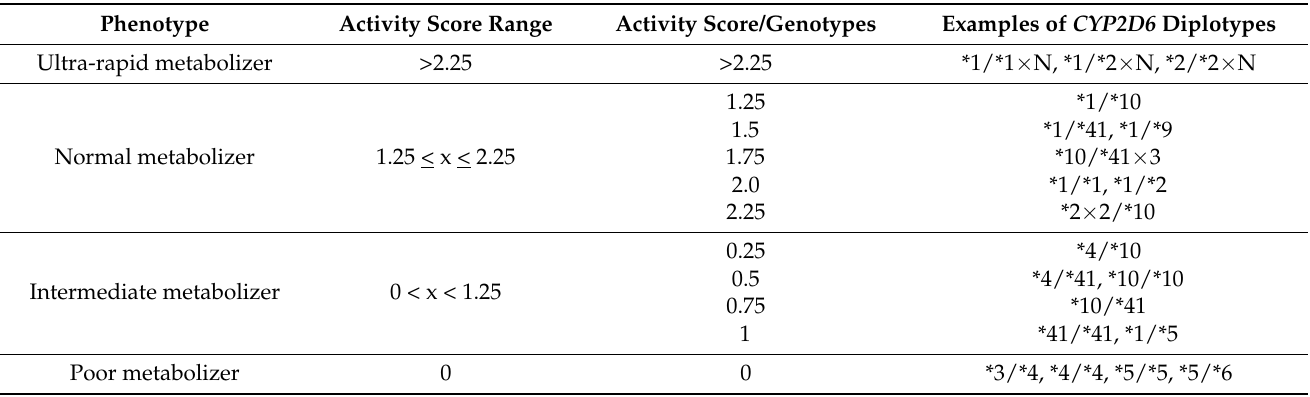
Table 1. Predicted CYP2D6 phenotypes based on